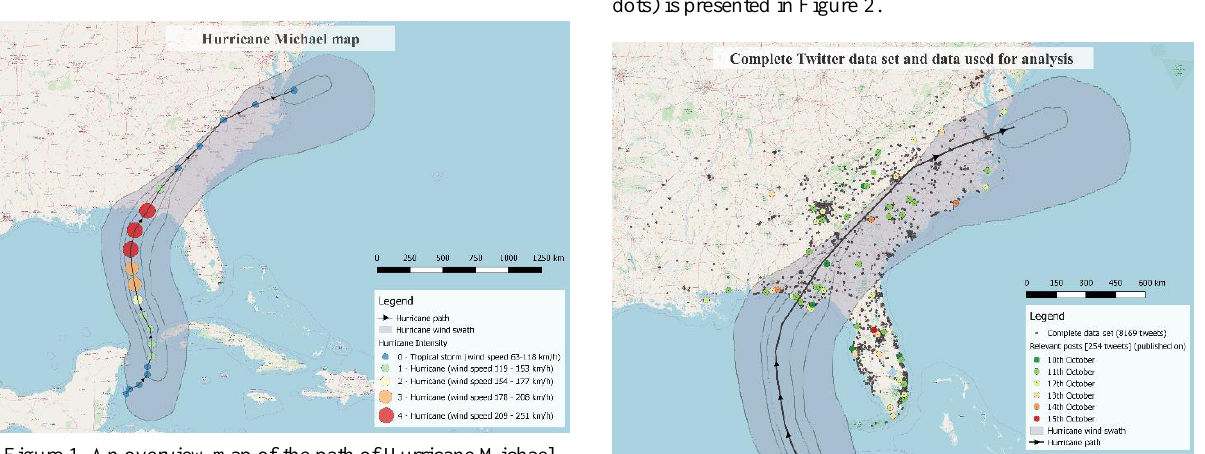
Figure 2. An overview of the complete tweet data set,